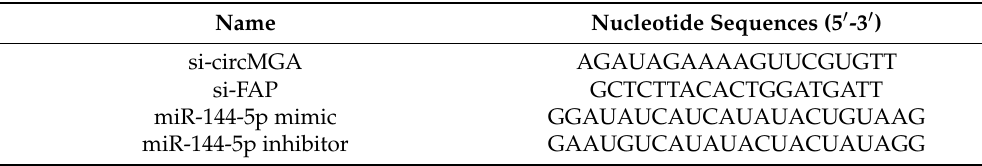
Table 2. Oligonucleotide sequences in this